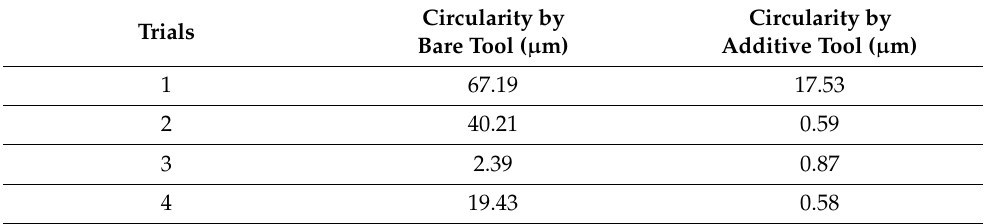
Table 4. Comparison table between Bare Tool and Additive Tool for